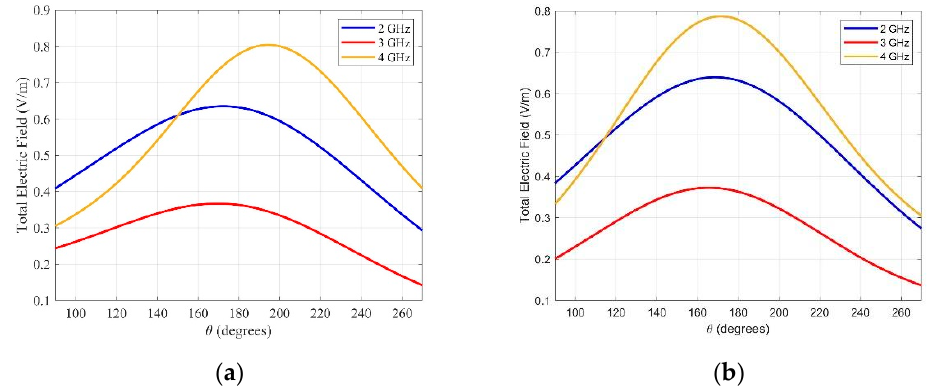
Figure 5. Back radiation electric field of the asymmetric Jerusalem cross antenna for ( a ) φ = 0 ◦ and ( b ) φ = 90 ◦ at di ff erent frequencies.